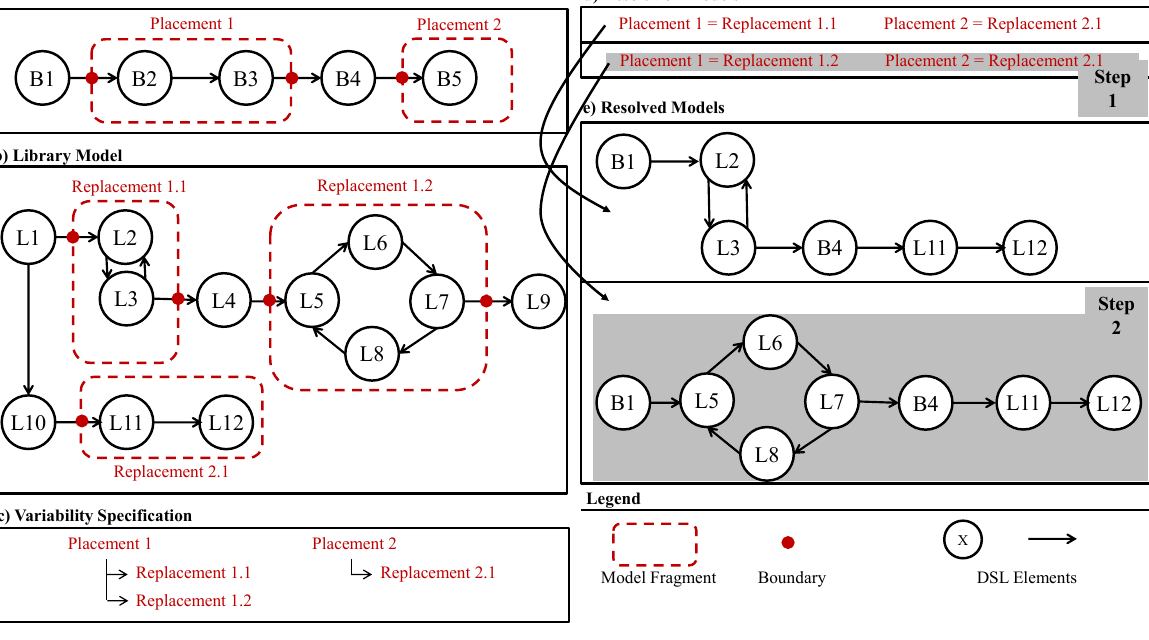
Figure 2. Configuration